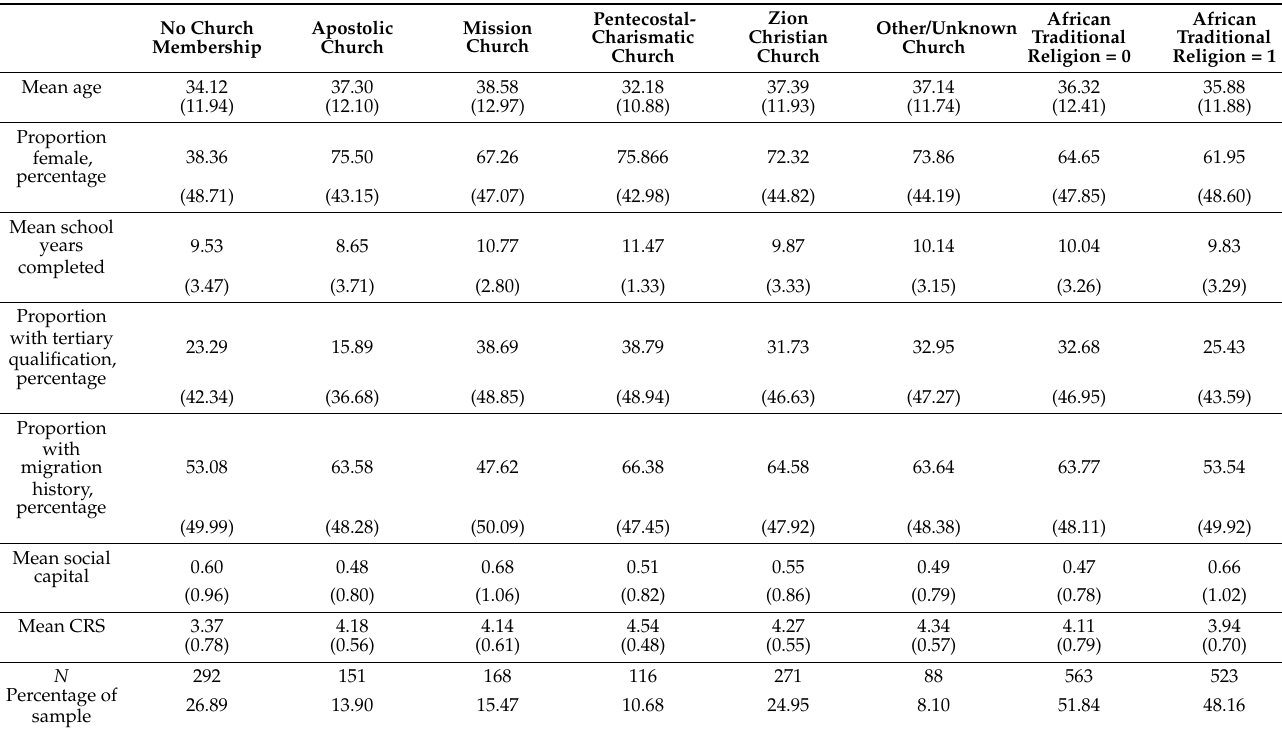
Table 2. Key summary statistics by church membership and African traditional religion.